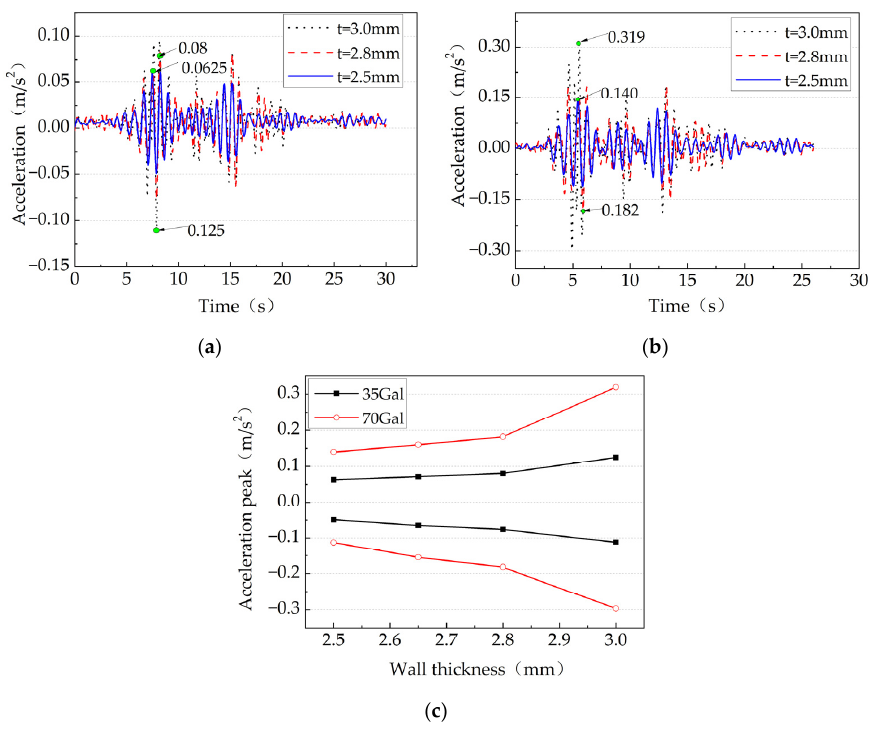
change at the top of the structure, the corrosion of the tower structure will lead to the local reduction of the structural stiffness, which will reduce the acceleration response and in- Figure 26. Comparison of structural accelerations under El Centro earthquake: ( a ) El Centro 35 Gal; crease the displacement response of the structure under the earthquake action. ( b ) El Centro 70 Gal; ( c ) Comparison of acceleration peak. It can be seen from Figure 27 that the corrosion causes the displacement of the top of the structure to increase, and the negative displacement of the structure is greater than the positive displacement of the structure. According to the analysis of the acceleration